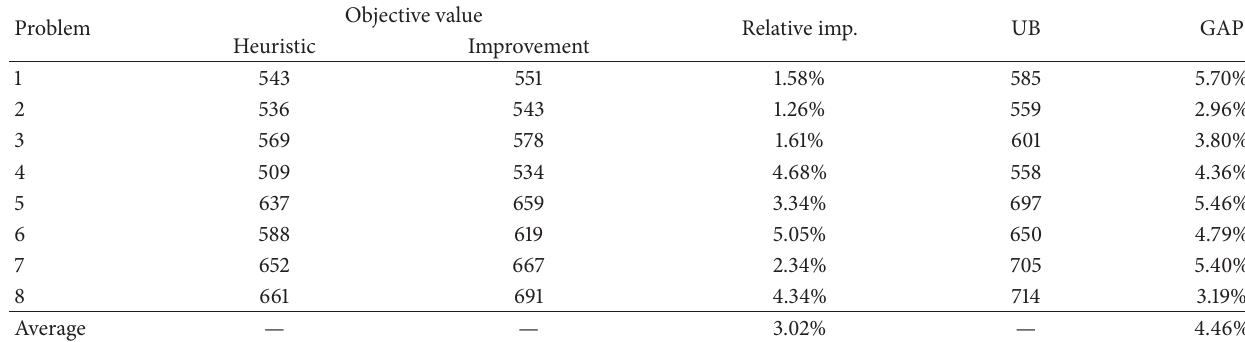
Table 3: Experiment result and comparison for the practical problem